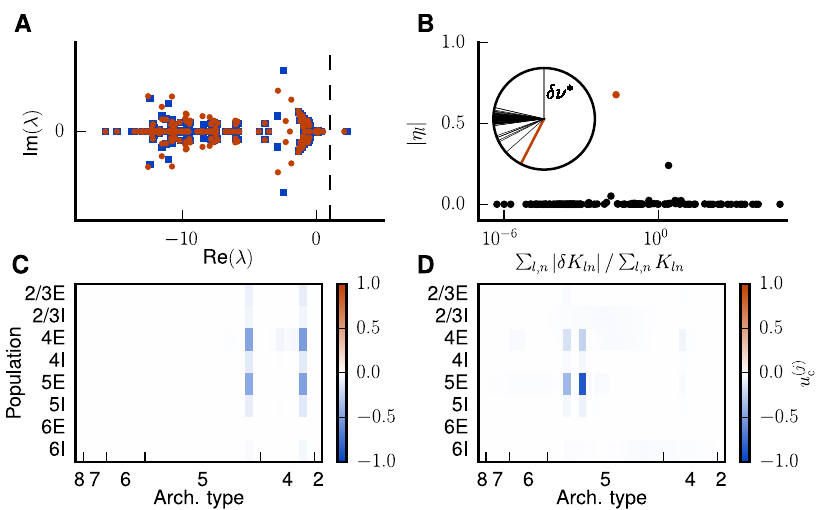
Fig 5. Eigenspectrum analysis of network stability. A Eigenvalue spectrum of the effective connectivity matrix M for the first (blue squares)and second (red dots) iteration. The dashedvertical line marks the edge of stability at a real part of 1. B Contribution Z (Eq (13)) of an individualeigenprojection l to the shift of the l unstablefixed point versus the relative changein indegrees associatedwith l for the first iteration. The data point corresponding to l ð 1 Þ is marked in red. The inset shows the relative anglesbetween δν (cid:3) and the c eigenvectors u l . The red line corresponds to the critical eigendirection. C Entries of the eigenvector u ð 1 Þ associated with l ð 1 Þ in the populationsof the model. The affected areas are 46 and FEF. D Same as C for the c second iteration.